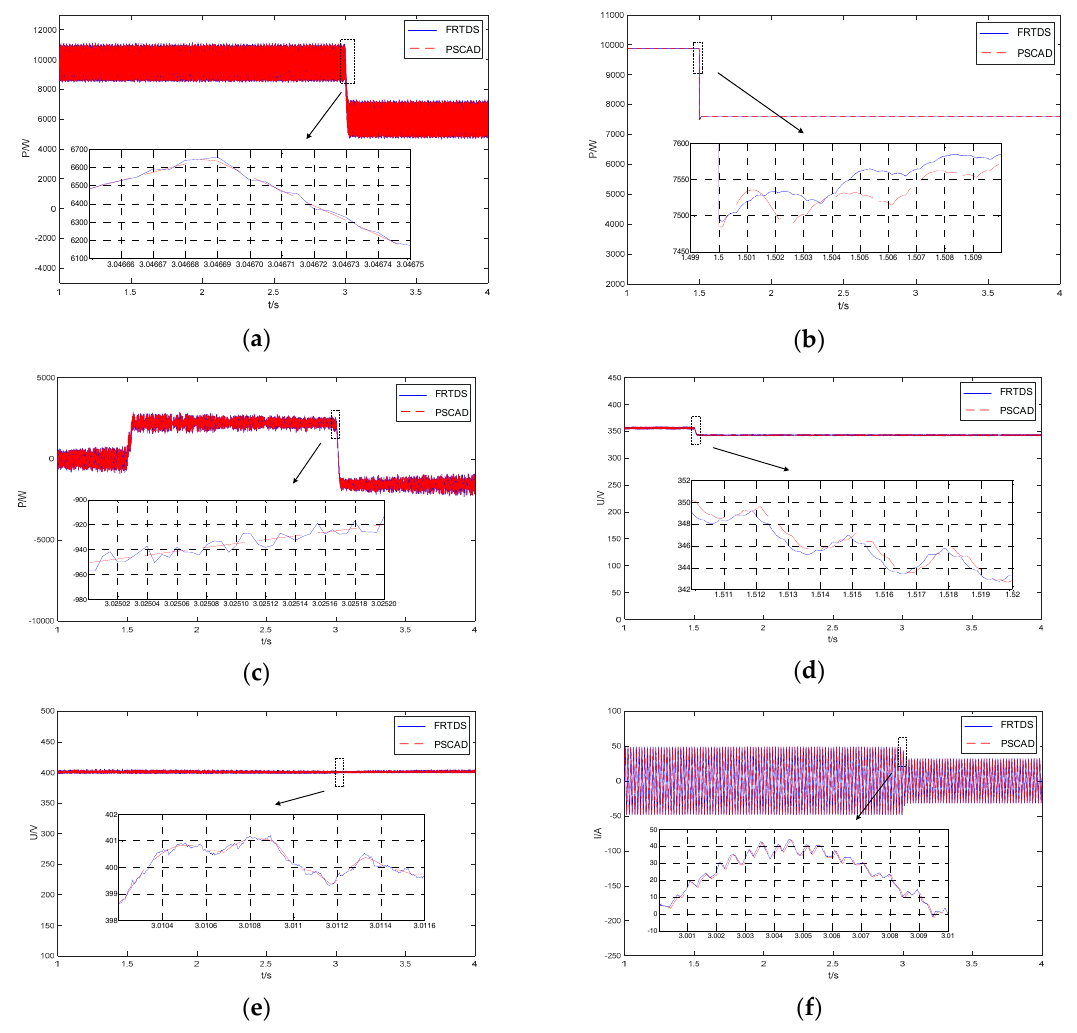
Figure 16. Simulation results of FPGA-based real-time digital simulation (FRTDS) and power systems computer aided design (PSCAD): ( a ) inverter output power; ( b ) photovoltaic array output power; ( c ) battery output power; ( d ) photovoltaic output voltage; ( e ) inverter Direct Current (DC) side voltage; ( f ) The filter output a phase